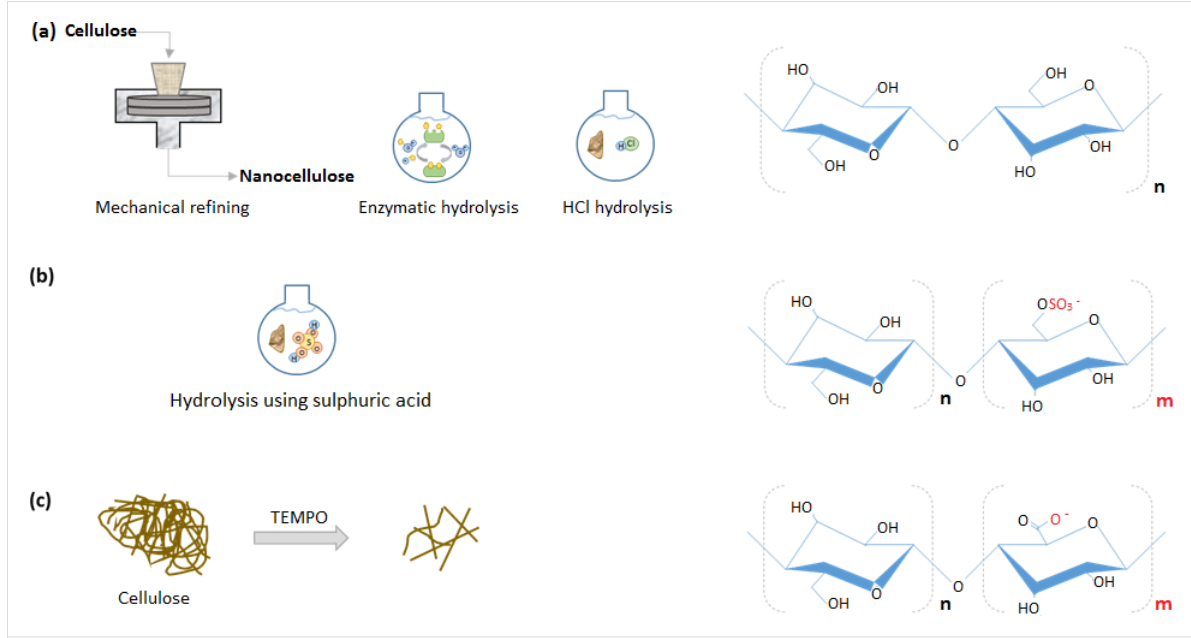
Figure 3: Resultant chemical structures of nanocellulose prepared via (a) mechanical refining, enzymatic hydrolysis, hydrolysis using hydrochloric acid, (b) hydrolysis using sulphuric acid, and (c) TEMPO-oxidation.